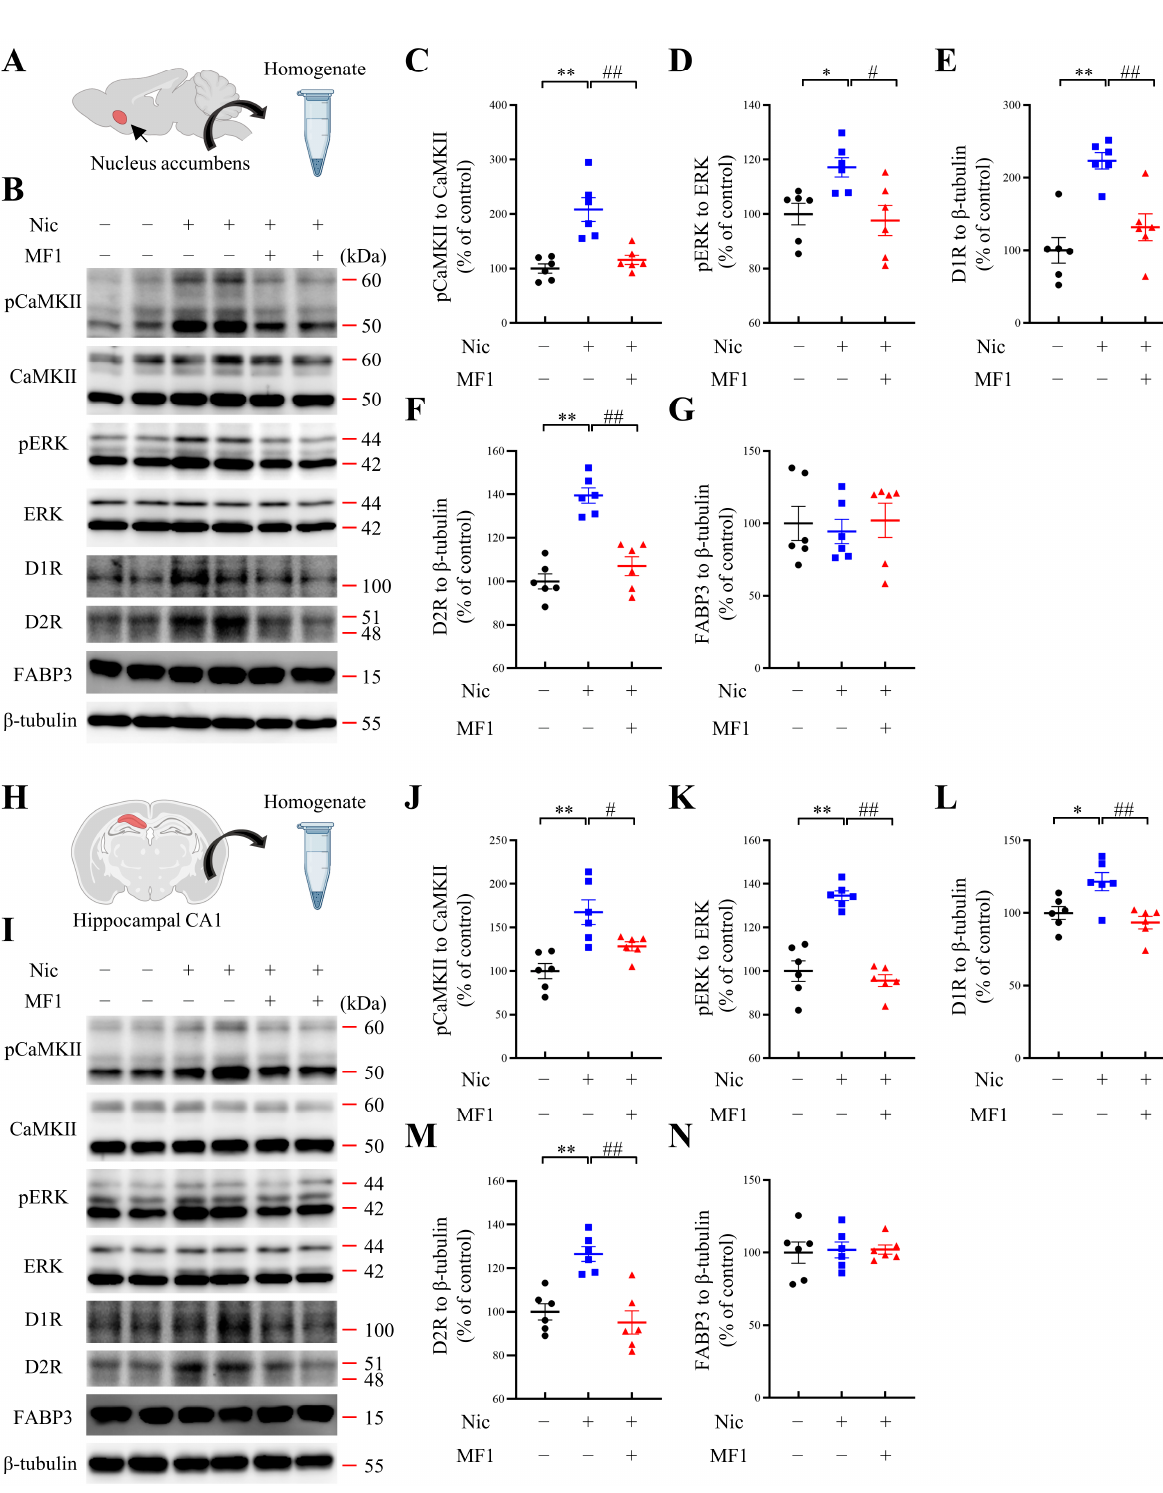
Figure 2. Kinase phosphorylation and DA receptor levels in CPP tasks. ( A – G ) Representative images and quantitative data for autophosphorylated CaMKII, CaMKII, phosphorylated ERK, ERK, D1R, D2R, FABP3, and β -tubulin in mouse NAc. Chronic nicotine exposure signi fi cantly increased levels of CaMKII autophosphorylation, ERK phosphorylation, D1R, and D2R, whereas these increases were clearly inhibited by pretreatment with MF1 ( n = 6 per group). * p < 0.05 vs. vehicle-treated group; ** p < 0.01 vs. vehicle-treated group; # p < 0.05 vs. nicotine-treated group; ## p < 0.01 vs. nicotine-treated group. ( H – N ) Representative images and quantitative data for autophosphorylated CaMKII, CaMKII, phosphorylated ERK, ERK, D1R, D2R, FABP3, and β -tubulin in mouse hippocampal CA1 region. Consistent with results observed in the NAc, signi fi cantly